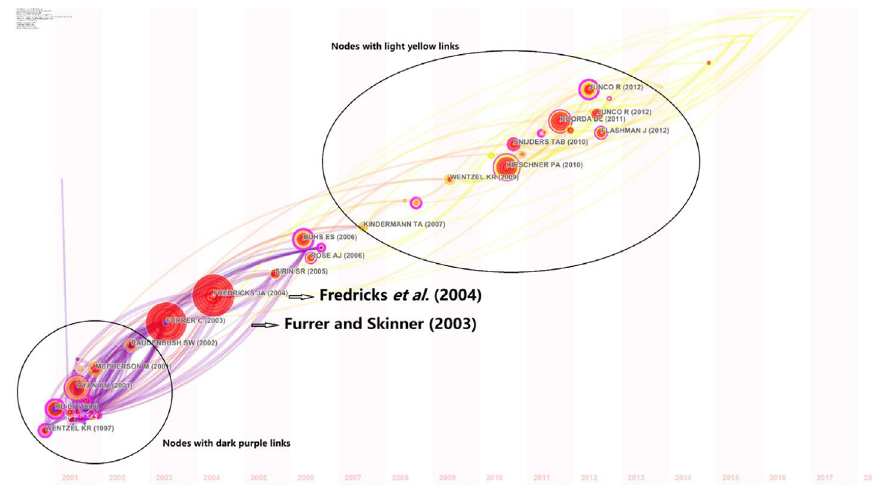
Figure 3. The merged network shows in time-zone view